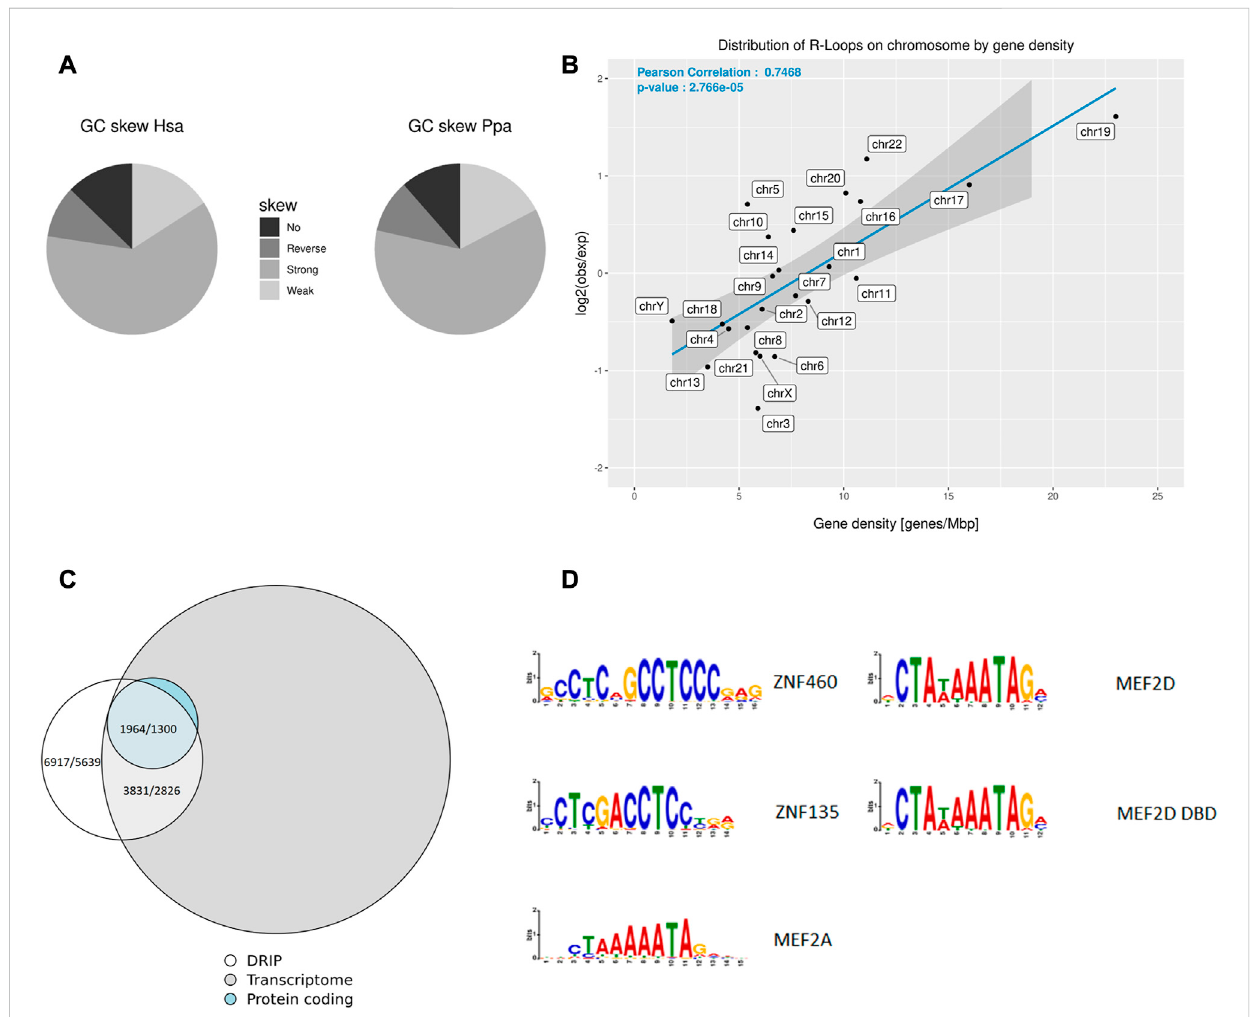
FIGURE 2 R-loop Distribution across the sperm genome and transcriptome. (A) Pie charts showing the distribution of human and bonobo genes with respect totheirGCskewaccordingtoSkewR. (B) RelativeproportionofR-loopsequencesperchromosomecomparedtothegenedensity ofthecorresponding chromosome. (C) Venn diagrams showing the overlap between the human protein-coding transcriptome and R-loops, indicated are values for each replicate. (D) Most enriched motifs in R-loops in human and